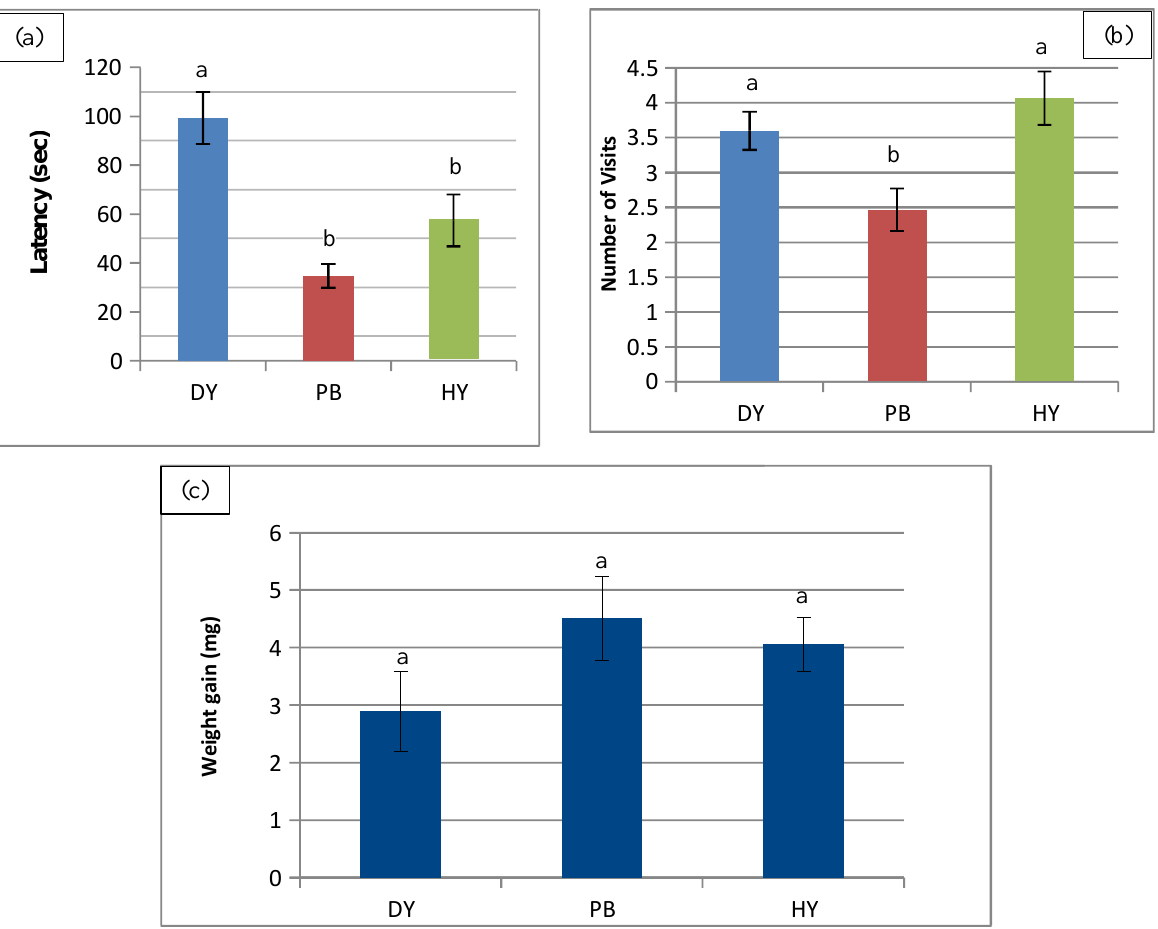
Figure 1. Feeding performance of B. germanica with solid diets (DY = dehydrated yeast; PB = peanut butter; HY = dehydrated yeast + water). Three parameters were observed: a) Latency; b) Number of visits to the source; c) Weight gain. Different letters indicate statistically significant